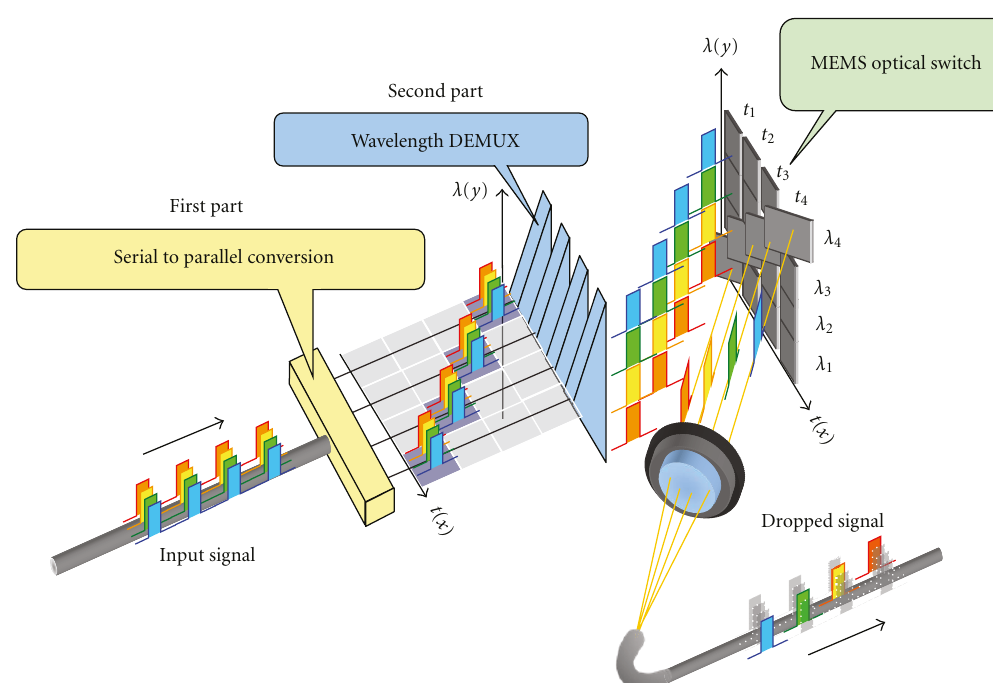
Figure 1: The schematic diagram of the proposed wavelength- and time-selective reconfigurable optical add/drop multiplexer.